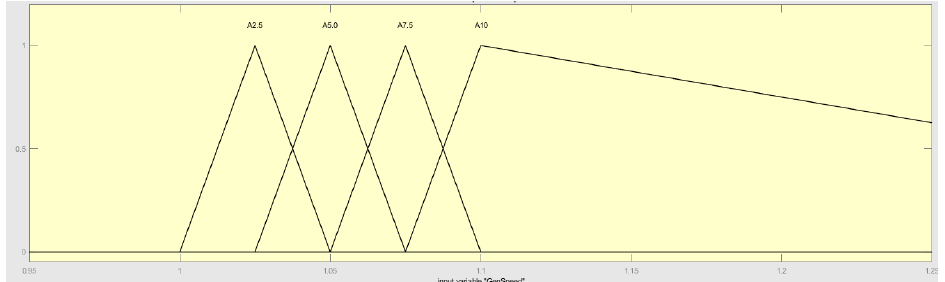
Figure 7. A zoom-in on the range [0.95, 1.25] of the horizontal axis of the membership functions for the generator speed inputs A2.5, A5.0, A7.5, and A10.